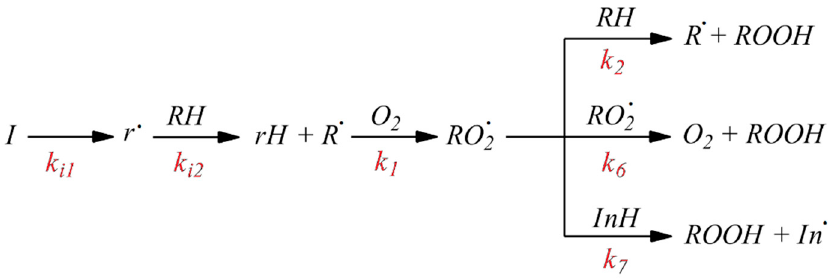
Figure 10. Mechanism of the inhibited radical chain oxidation of organic compounds (I, RH and InH are the initiator, oxidized substrate, and inhibitor, respectively), where I is the initiator of the